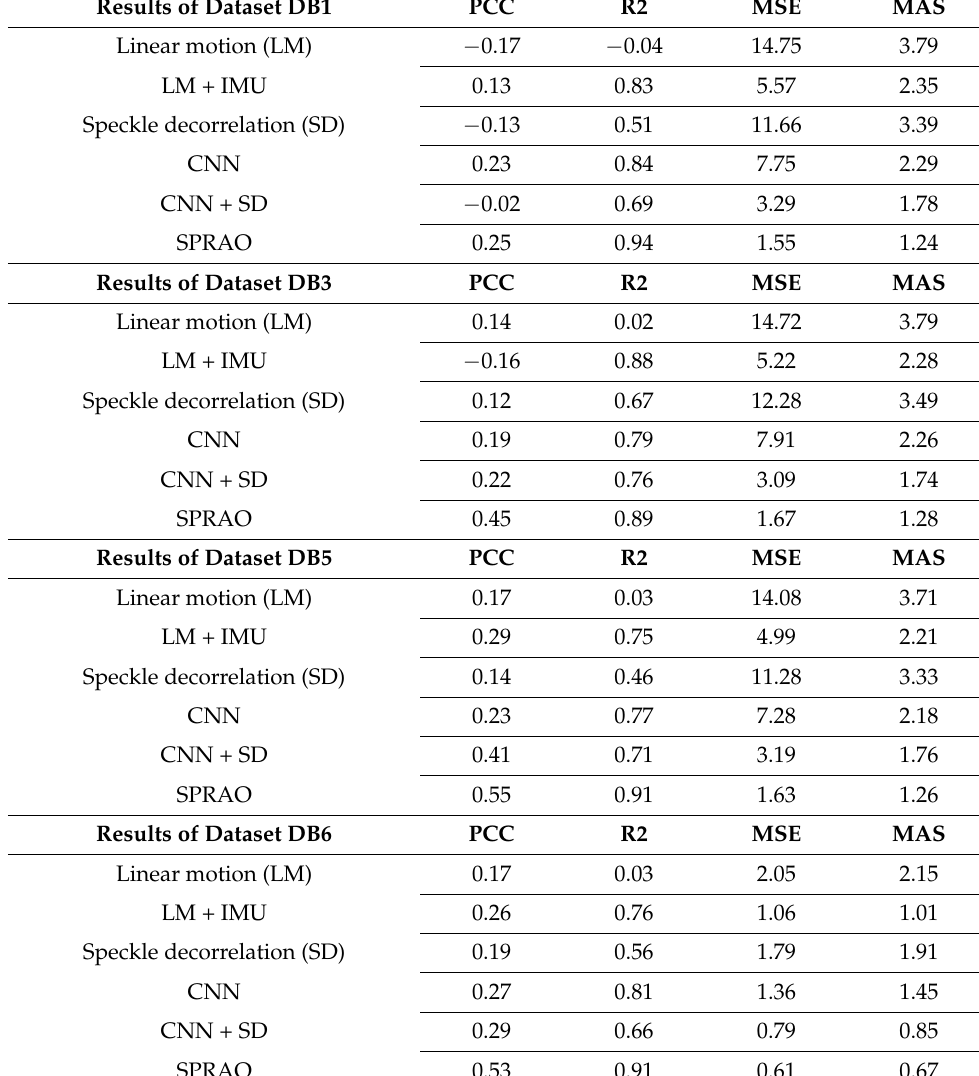
Table 4. Different evaluation methods compare the prediction results and fitting